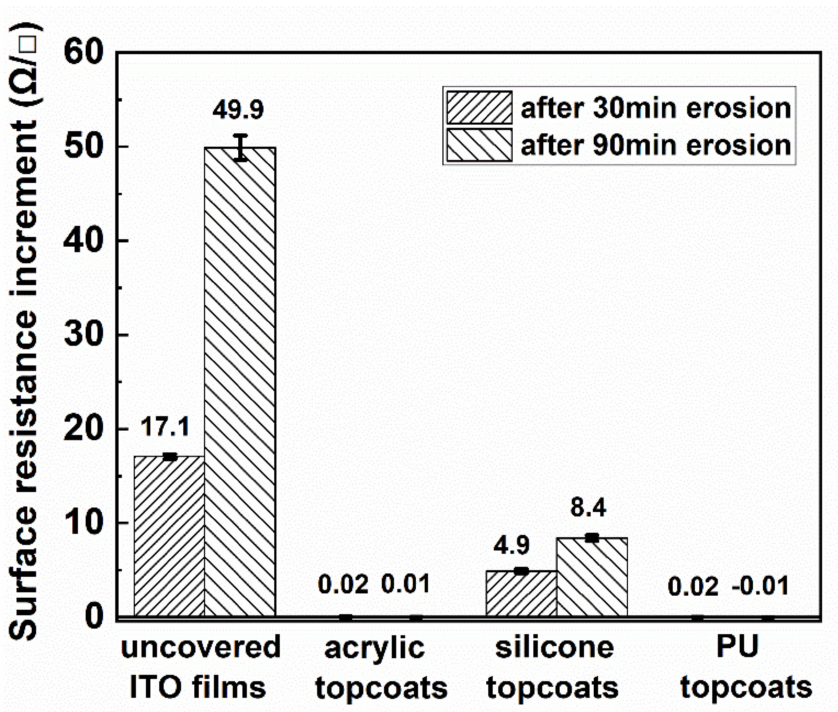
Figure 8. Variation in surface resistance of uncovered ITO films, ITO films covered by acrylic-based, silicone and PU topcoats after sand erosion for 30 min and 90